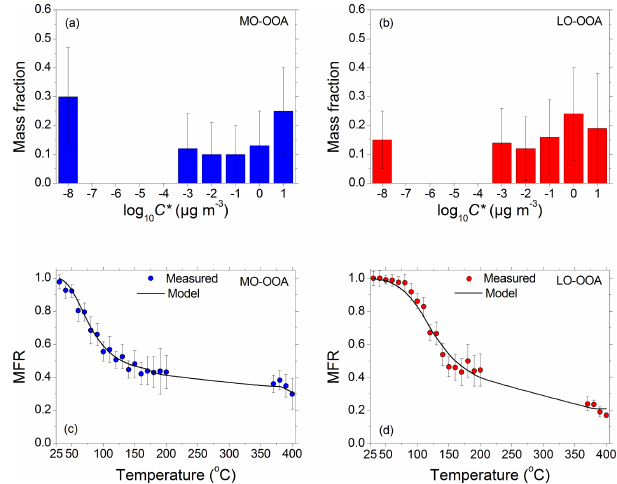
Figure 4. (a) Estimated volatility distribution of the more oxidized oxygenated OA (MO-OOA) factor, along with its corresponding un- certainties, by using the approach of Karnezi et al. (2014). (b) Es- timated volatility distribution of the less oxidized OA (LO-OOA) factor, along with its corresponding uncertainties. (c) Measured (in circles) and predicted thermograms for the MO-OOA factor. The er- ror bars represent ± 2 standard deviations of the mean. (d) Measured (in circles) and predicted thermograms for the LO-OOA factor. The error bars represent ± 2 standard deviations of the